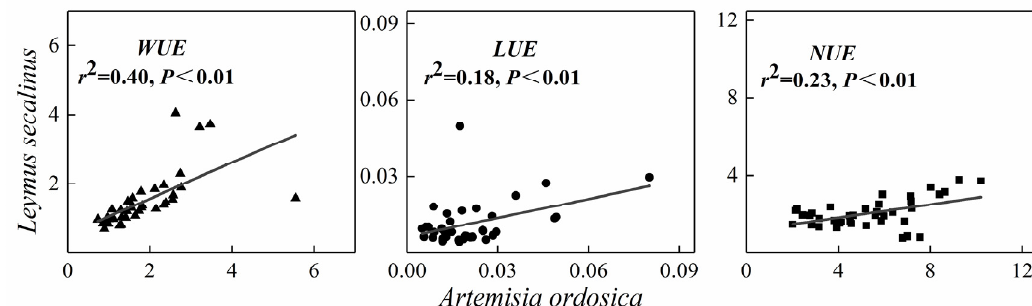
Figure 8. Pairwise correlations of WUE , LUE , and NUE for A. ordosica and L. secalinus ; R is the coefficient of correlation and p provides the level of significance.